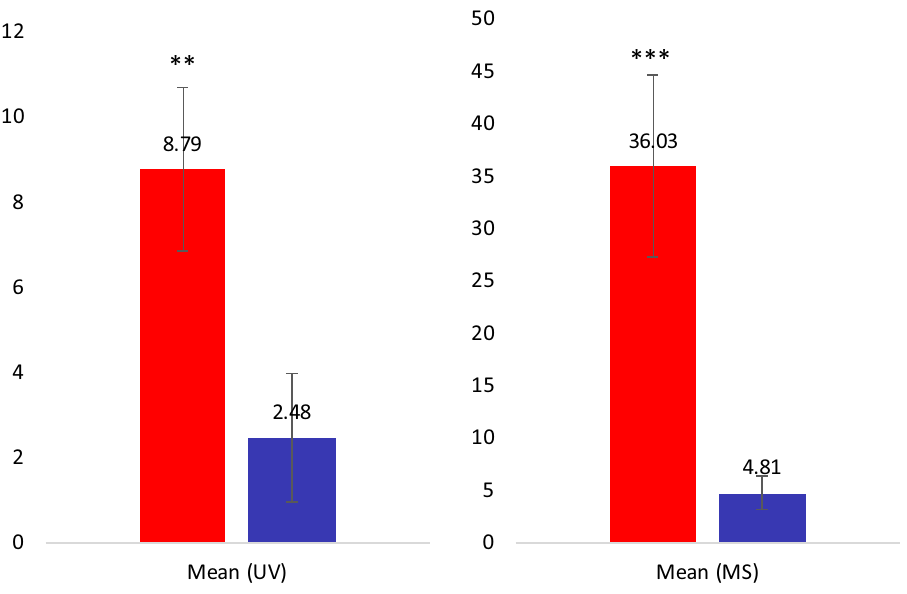
Figure 3. Mean HHQ/HQNOC9:1 ratio ± SEM detected in chronic strains (PC + PCM, n = 20; in red) and in first colonisation strains (PP + PF, n = 19; in blue), using both UV (left) and HRMS (right) data. Significant differences were found by using Kruskal–Wallis tests (chi-squared = 8.7066, df = 1, p-value = 0.003171 for UV, and chi-squared = 18.723, df = 1, p-value = 1.511 × 10 –5 for